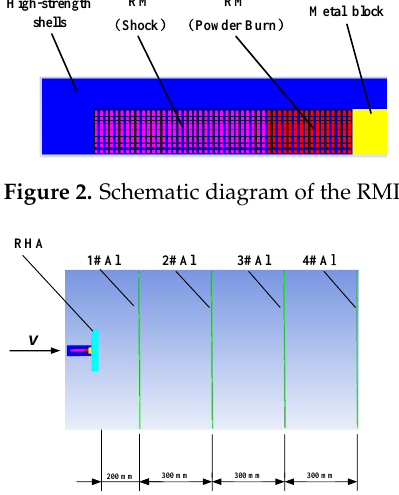
Figure 3. Three-dimensional penetration analysis model.